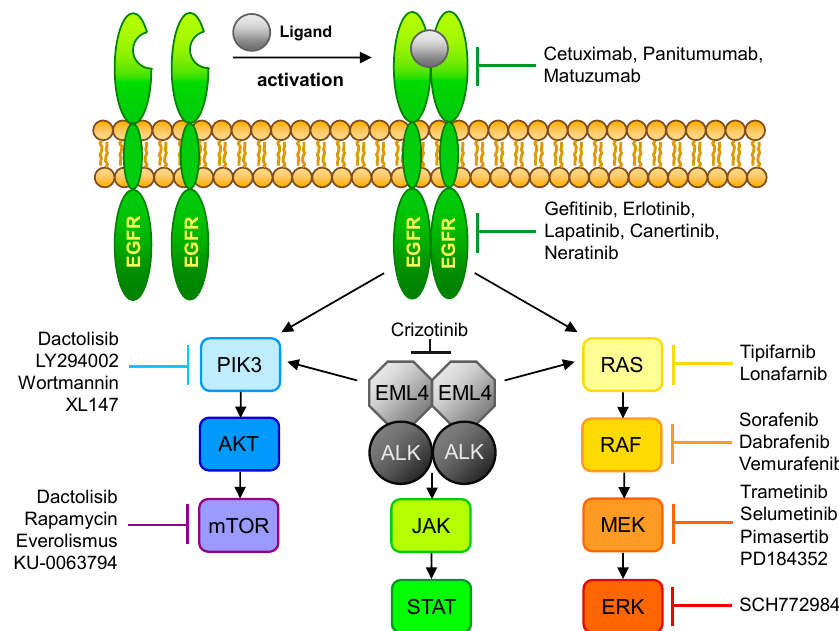
Figure 2. Overview of the EGFR - and ALK -signaling pathways and their respective inhibitors. Ligand binding to EGFR leads to dimerization of the receptor, resulting in phosphorylation of the tyrosine kinase domain and activation of the PIK3 / AKT / mTOR or the RAS/RAF/MEK/ERK signaling pathway. This signal transduction cascade could also be activated via EML4 - Alk which, in turn, may initiate the JAK / STAT pathway. The affected pathways control cell growth and play a role in cell differentiation.